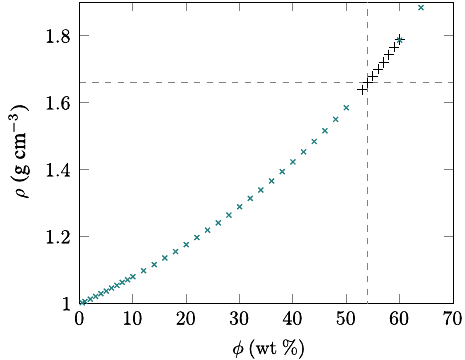
FIG. 7. Density of water-cesium chloride mixtures as a function of the cesium chloride mass fraction ϕ . The data below ϕ ¼ 50 wt % was retrieved from Ref. [65]. Measurements above ϕ ¼ 50 wt % were performed at a temperature of 22 °C using an acoustic resonance densimeter (Anton Paar DMA 35). Dotted lines show that matching the cornstarch density of 1.63 requires ϕ ¼ 54 wt % .